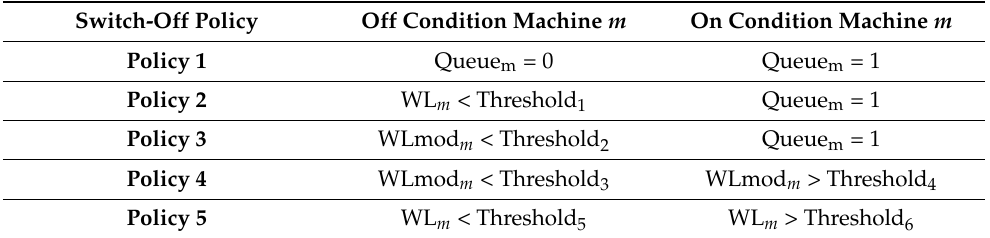
Table 1. Switch-off policies investigated.